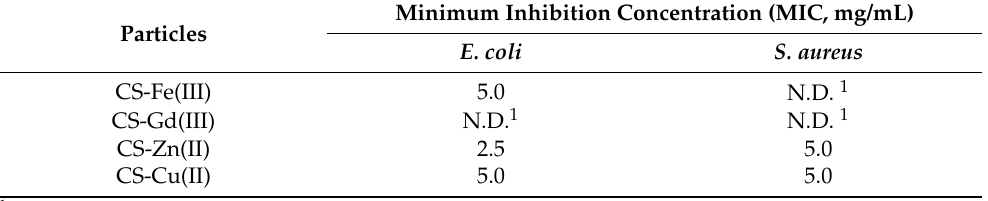
Table 1. Antibacterial activity of CS-Fe(III), CS-Gd(III), CS-Zn(II), and CS-Cu(II) particles by mini- mum inhibition concentration (MIC) values against Gram-negative Escherichia coli ATCC 8739 and